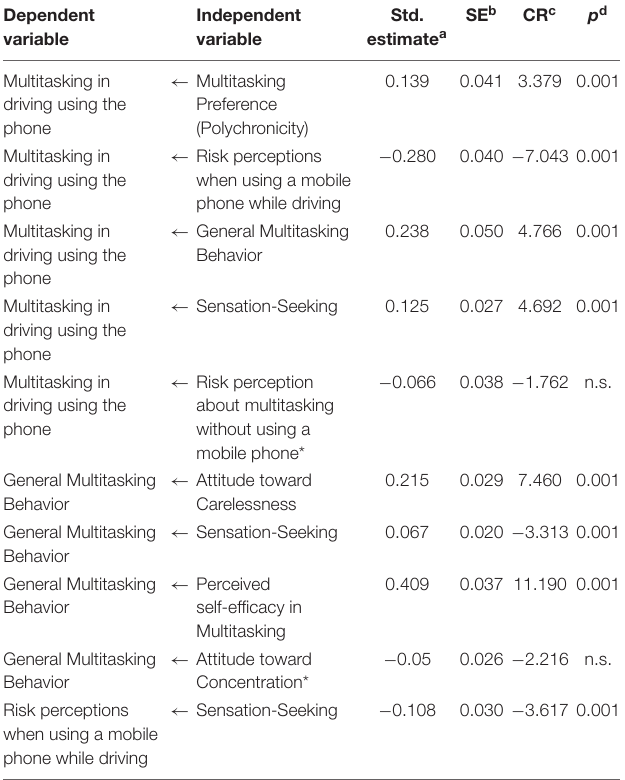
TABLE 2 | Structural Equation Model (SEM) for predicting the multitasking in driving using the